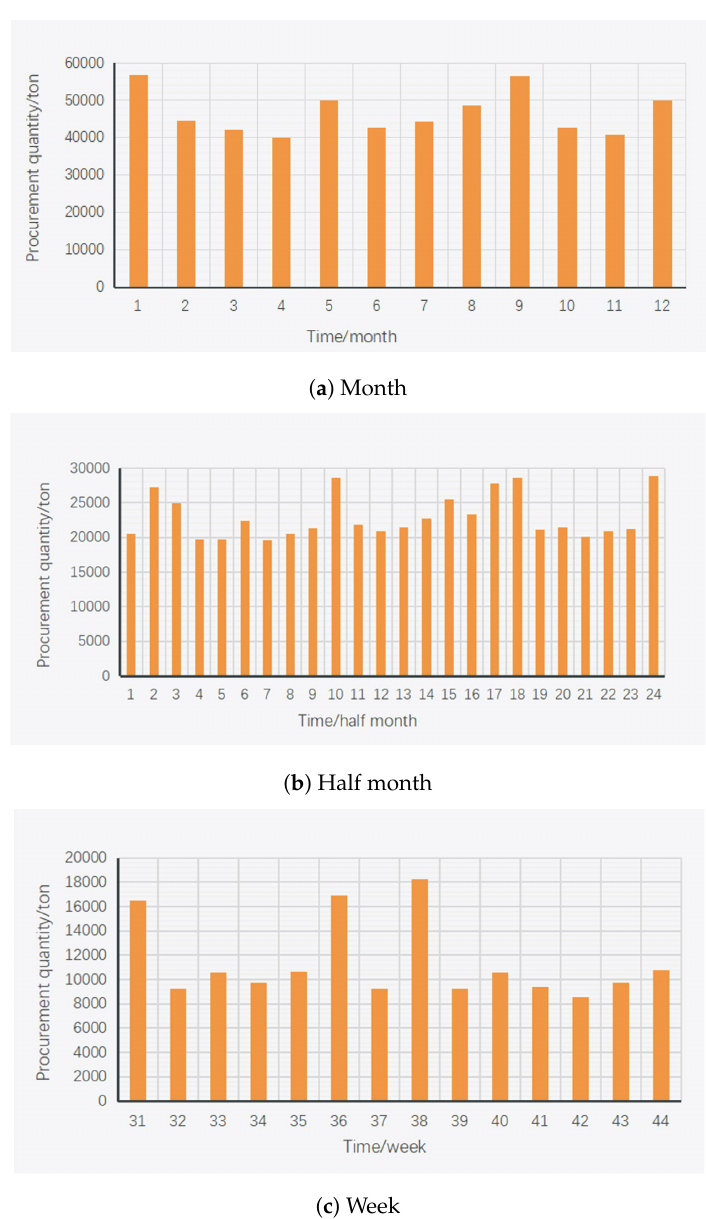
Figure 3. Raw material procurement data trend